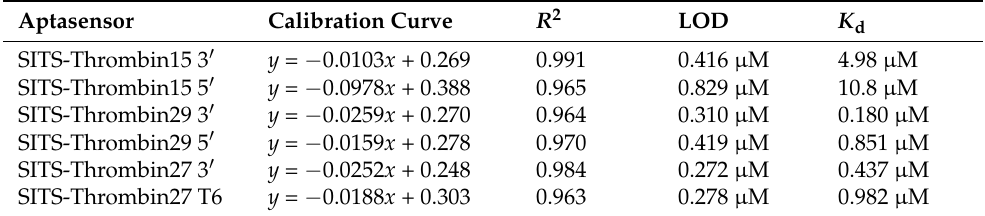
Figure 12. ( A ) The apparent fluorescence attenuation rate constant k app of different SITS-TAs in the presence and absence of 7.5 µ M thrombin. ( B ) The corresponding difference in k app ( ∆ k app ). Table 1. The Calibration Curves and LODs of the Additional Six SITS-TAs.